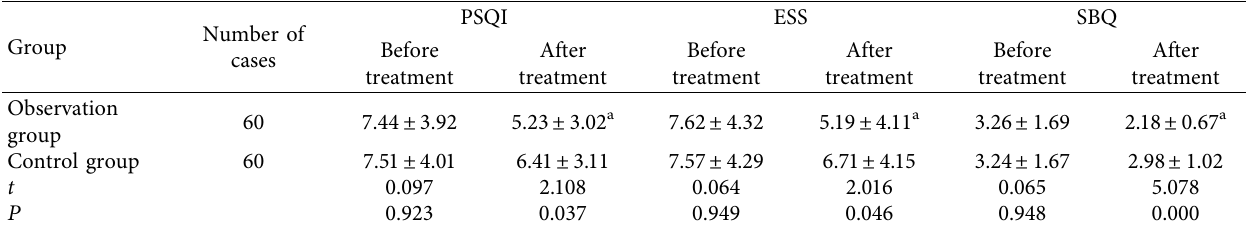
Table 3: Comparison of sleep quality between the two groups of patients ( x − ± s , points). Group Observation group